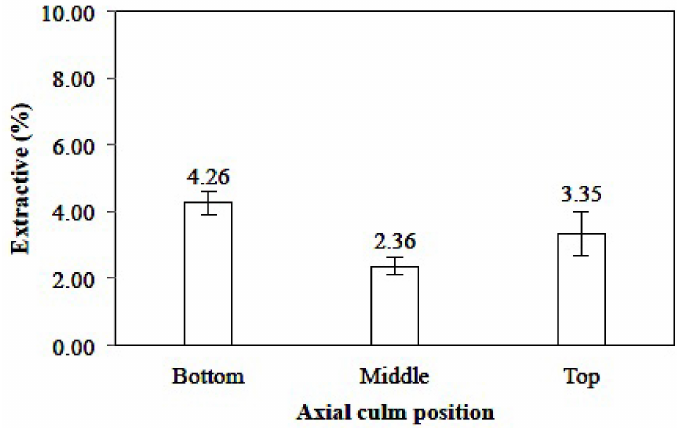
Figure 10. Extractive solubility in ethanol benzene (1:2) of Gigantochloa pruriens .